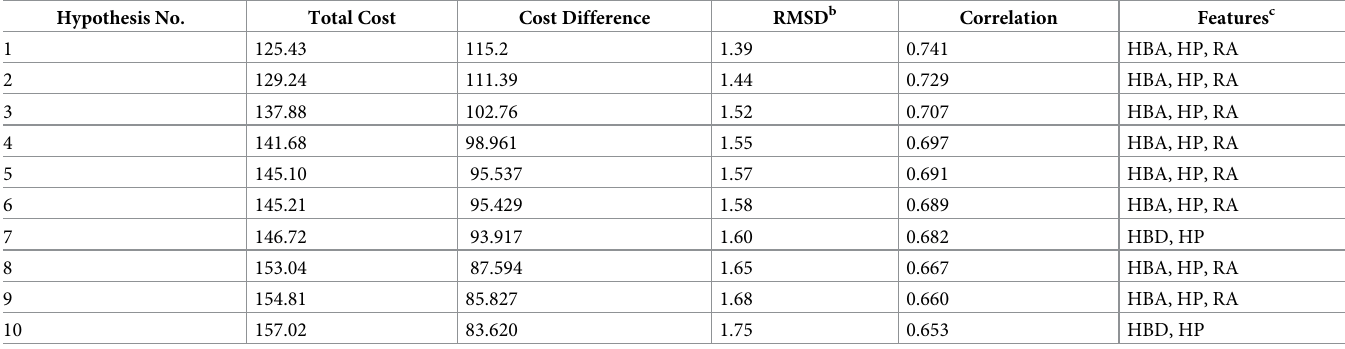
The null cost and the fixed cost are 240.64 and 109.19, respectively a Cost difference between the null and the total cost b RMSD, root mean square deviation c